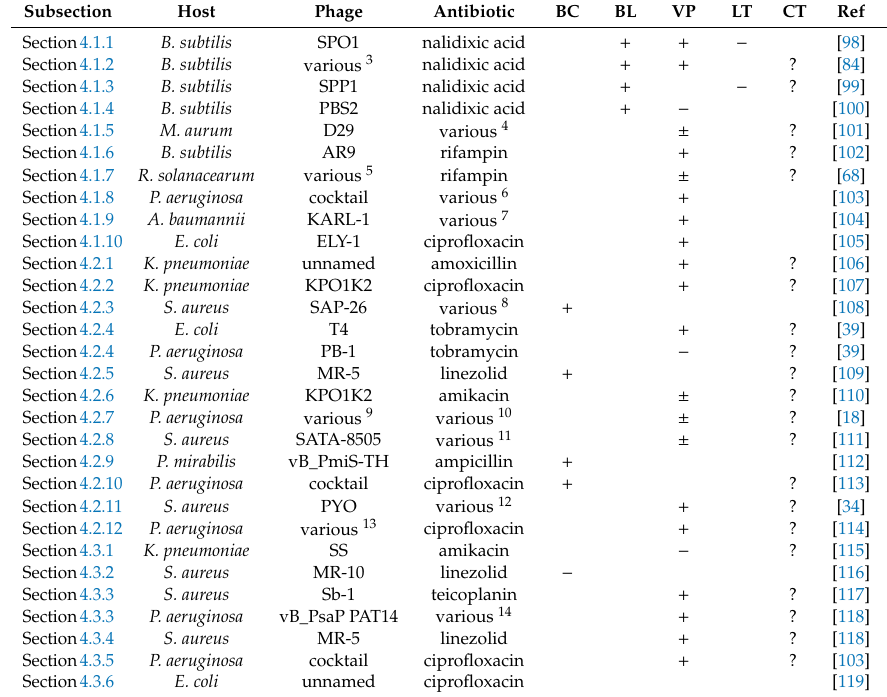
Table 2. Studies suggesting retention of phage infection activity in the presence of antibiotics 1,2